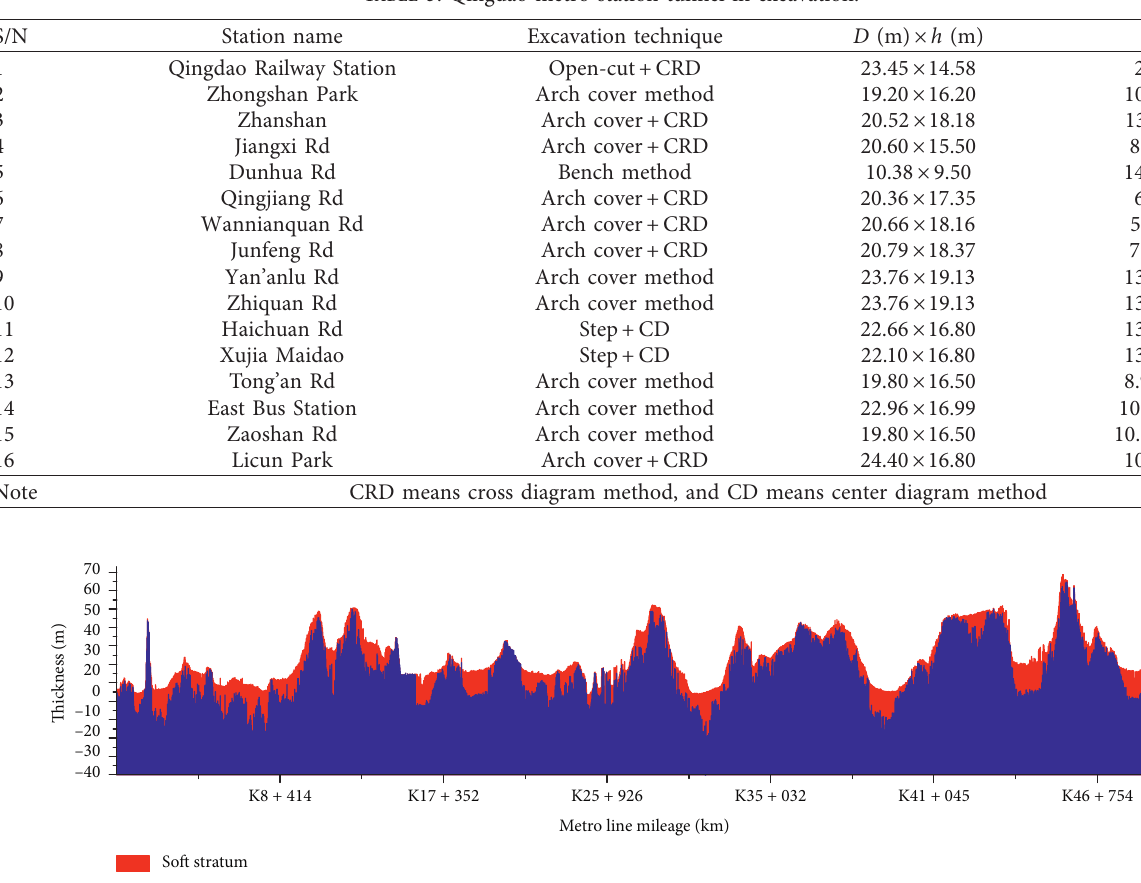
Table 5: Qingdao metro station tunnel in excavation.